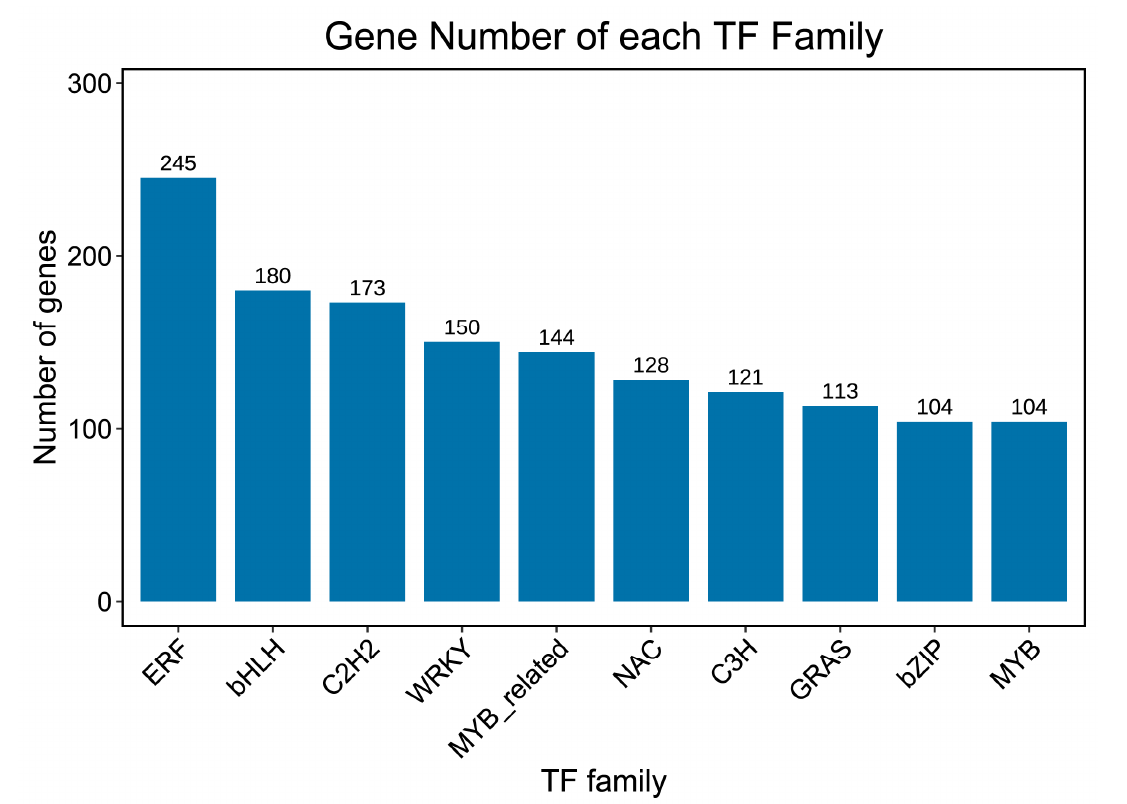
Figure 6. Transcription factor statistics. The “X” axis shows the top 10 transcription factor families, and the “Y” axis represents the number of genes.